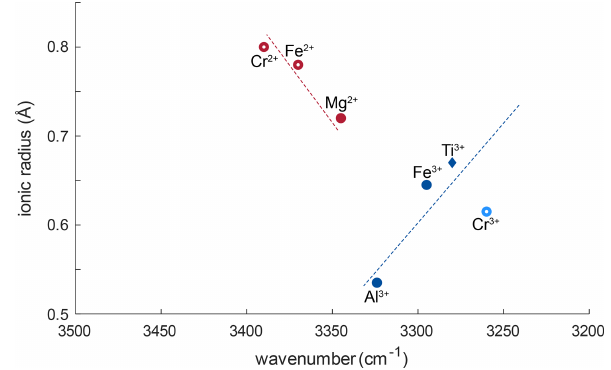
Figure 8. Ionic radii (Shannon, 1976) vs. wavenumber of trace- element-related OH bands. Blue symbols correspond to trivalent cations, red symbols to divalent cations. Filled symbols represent trace elements identified from literature; open red circles repre- sent previously unreported OH-band positions. The approximate linear relationship between ionic radius of the trace element and wavenumber of the related OH bond for trivalent cations is repre- sented as blue dotted line. The red dashed line shows the approx- imate linear trend that can be assumed for divalent cations. Open, light blue circles represent possible OH bands for Cr 3 + (Bromiley and Hilairet, 2005) that were not observed in this